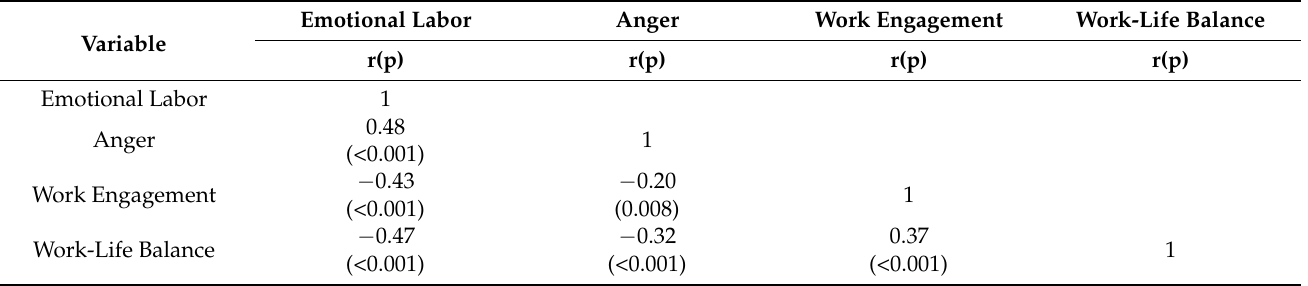
Table 3. Correlations among Emotional Labor, Anger, Work Engagement, and Work-Life